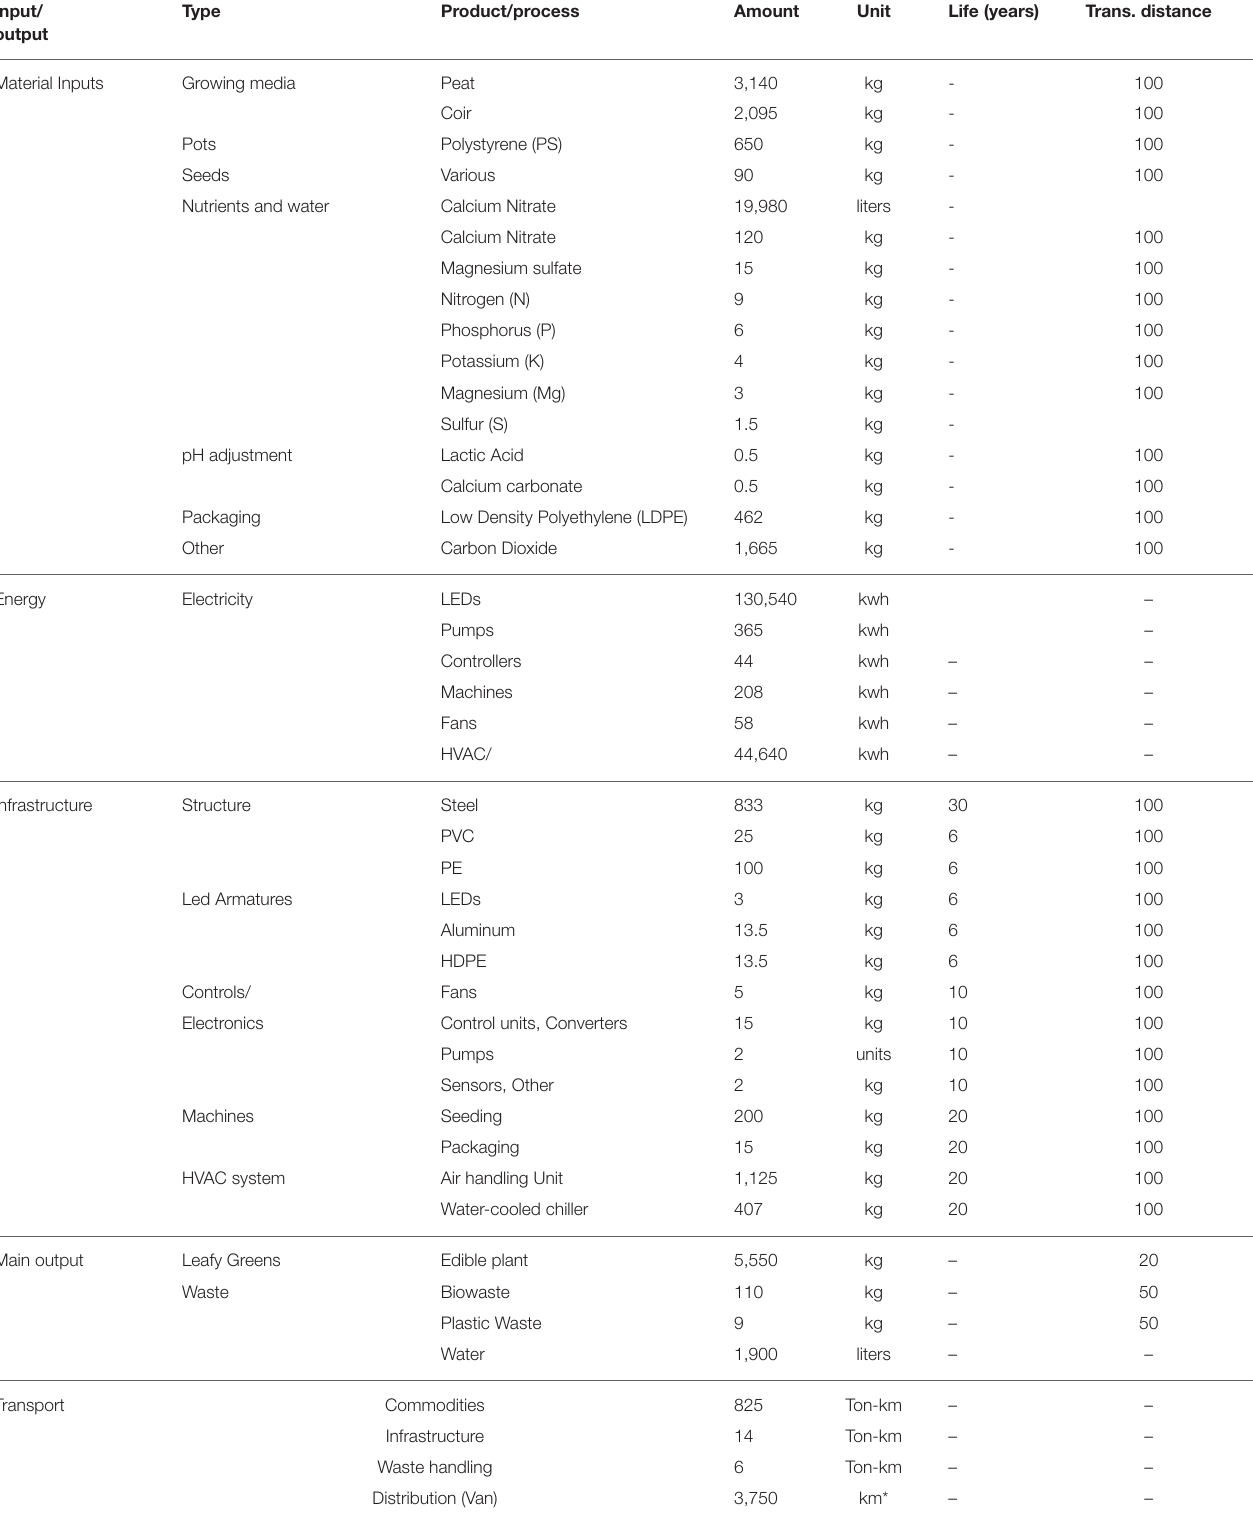
TABLE 1 | Annual inputs-outputs for the reference scenario vertical